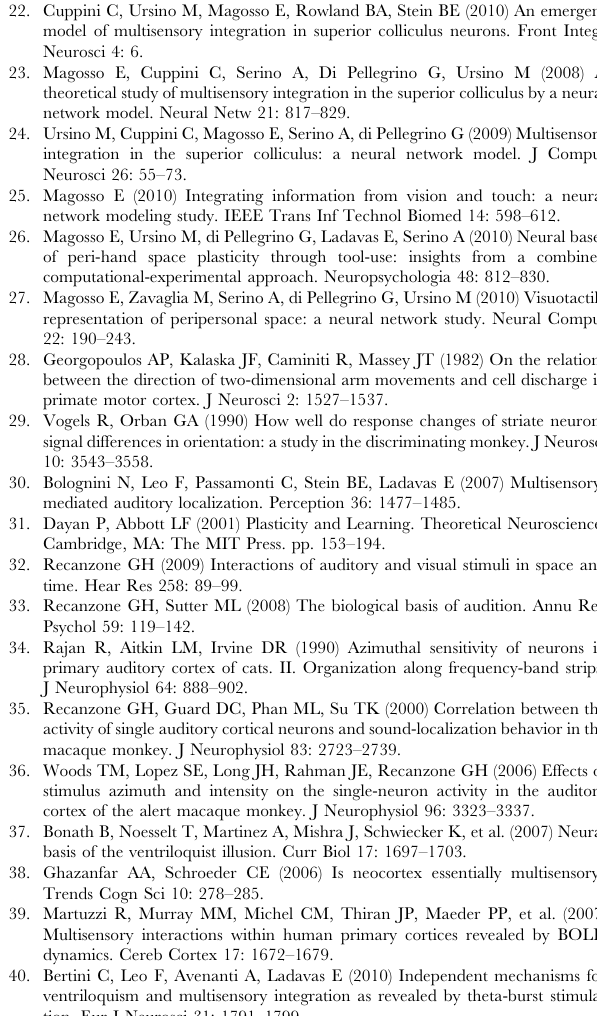
Figure S3 Alternative coding of cue reliability. Here we tested network functioning when cue reliability is coded in the strength (rather than the width) of the input. That is, here we assumed that the visual and auditory inputs have the same standard deviation ( s v = s a= 35 u ) but different strengths. All other mechanisms and parameters have been maintained unaltered. The three parts of the figure display visual (blue line) and auditory (red dashed line) activity in response to different stimulations. ( A ) Network activity in response to an unimodal visual stimulus applied at position p v = 120 u . The visual stimulus had strength E v = 16 ( s v = 35 u ). The displayed activation refers to steady-state 0 condition (after the transient response was exhausted). ( B ) Network activity in response to an unimodal auditory stimulus applied at position p a = 100 u . The auditory stimulus had strength E a ( s a = 35 u ). The displayed activation refers to steady-state